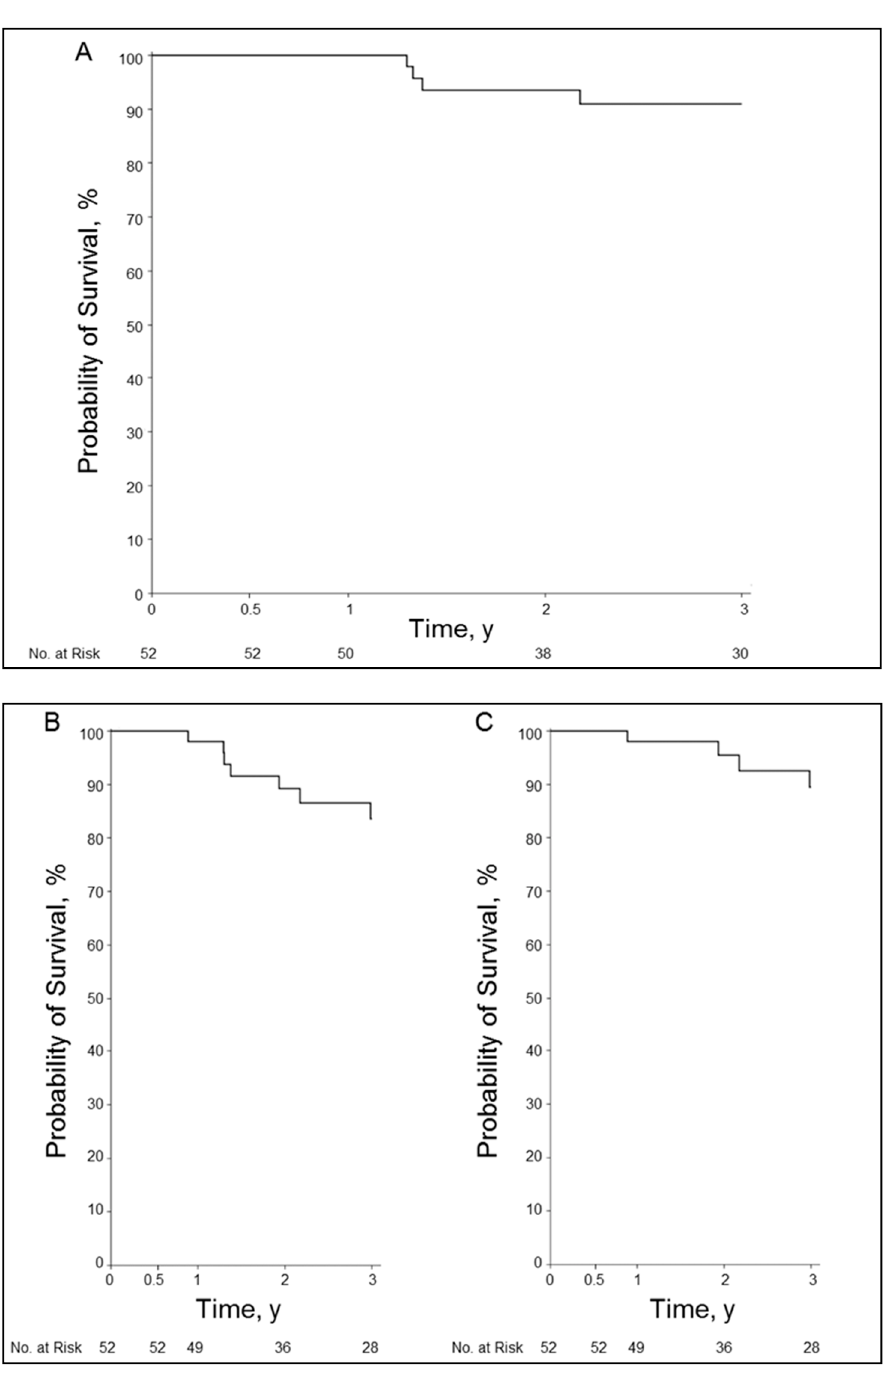
Figure 3. Results of stent treatment for hepatic artery stenosis. ( A ), Kaplan–Meier curve for overall survival. ( B ), Kaplan–Meier curve for graft survival. ( C ), Kaplan–Meier curve for graft survival with liver-related death. y,